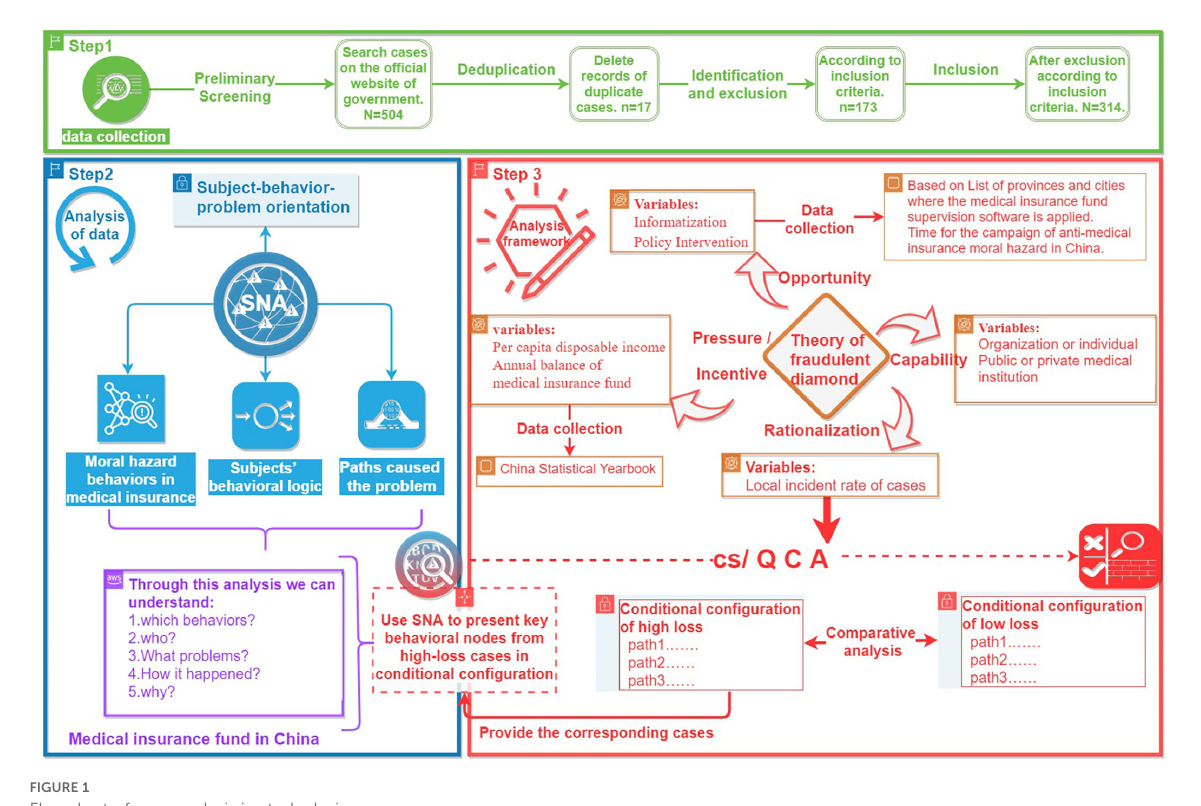
FIGURE1 Flowchart of case analysis in study